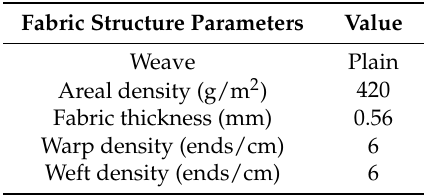
Table 2. The properties of Kevlar